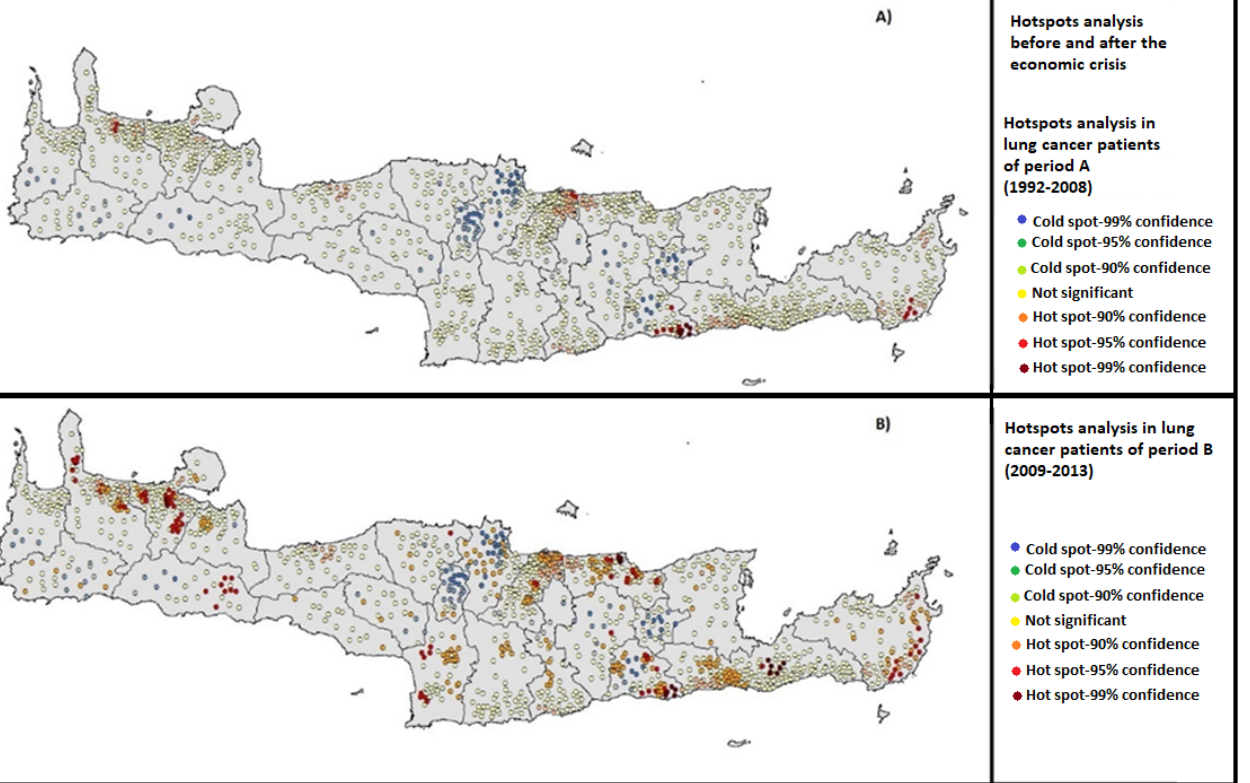
Figure 1. Hotspots analysis of LC cases in Crete: ( A ) before and ( B ) after the economic crisis, ( n = 5057).